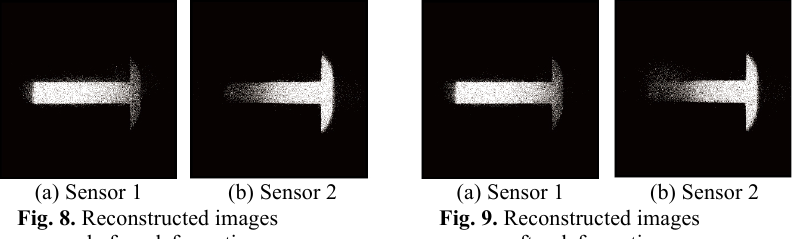
after deformation